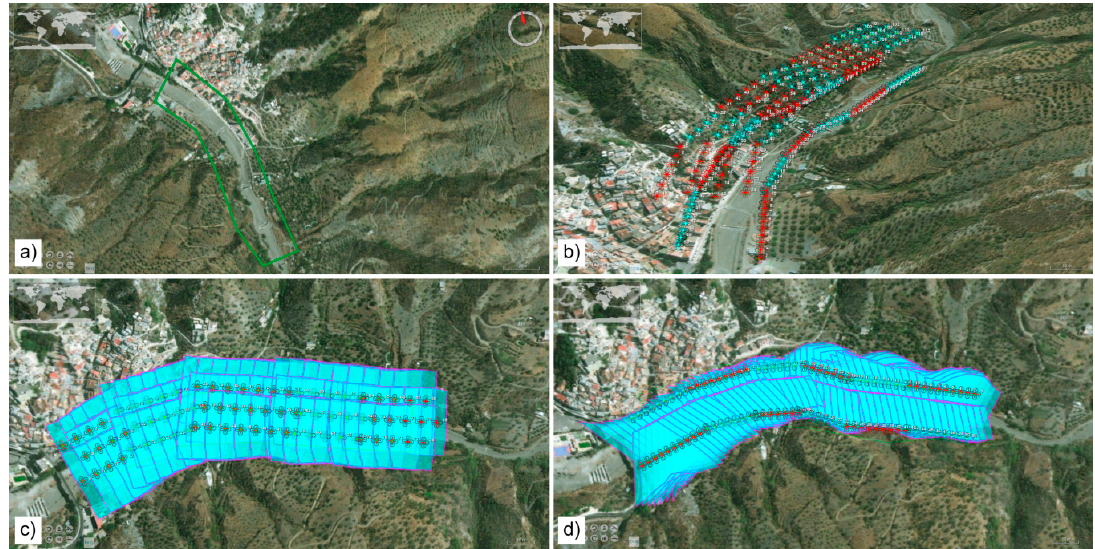
Figure 10. Linear case planning: ( a ) study zone, ( b ) position and orientation of planned images, ( c ) block flight, and ( d ) convergent flight.